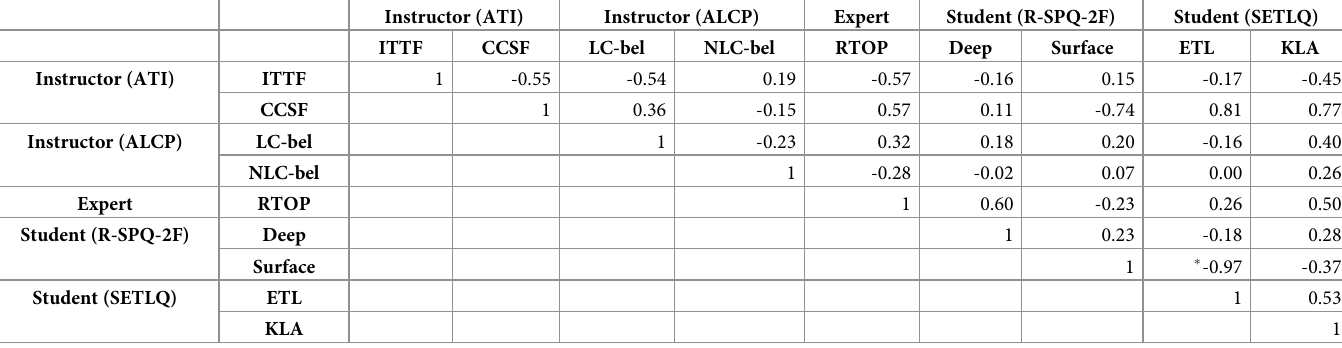
Table 2. Pearson correlations between primary instructor subscales, primary student subscales, and RTOP scores across all sections. Instructor